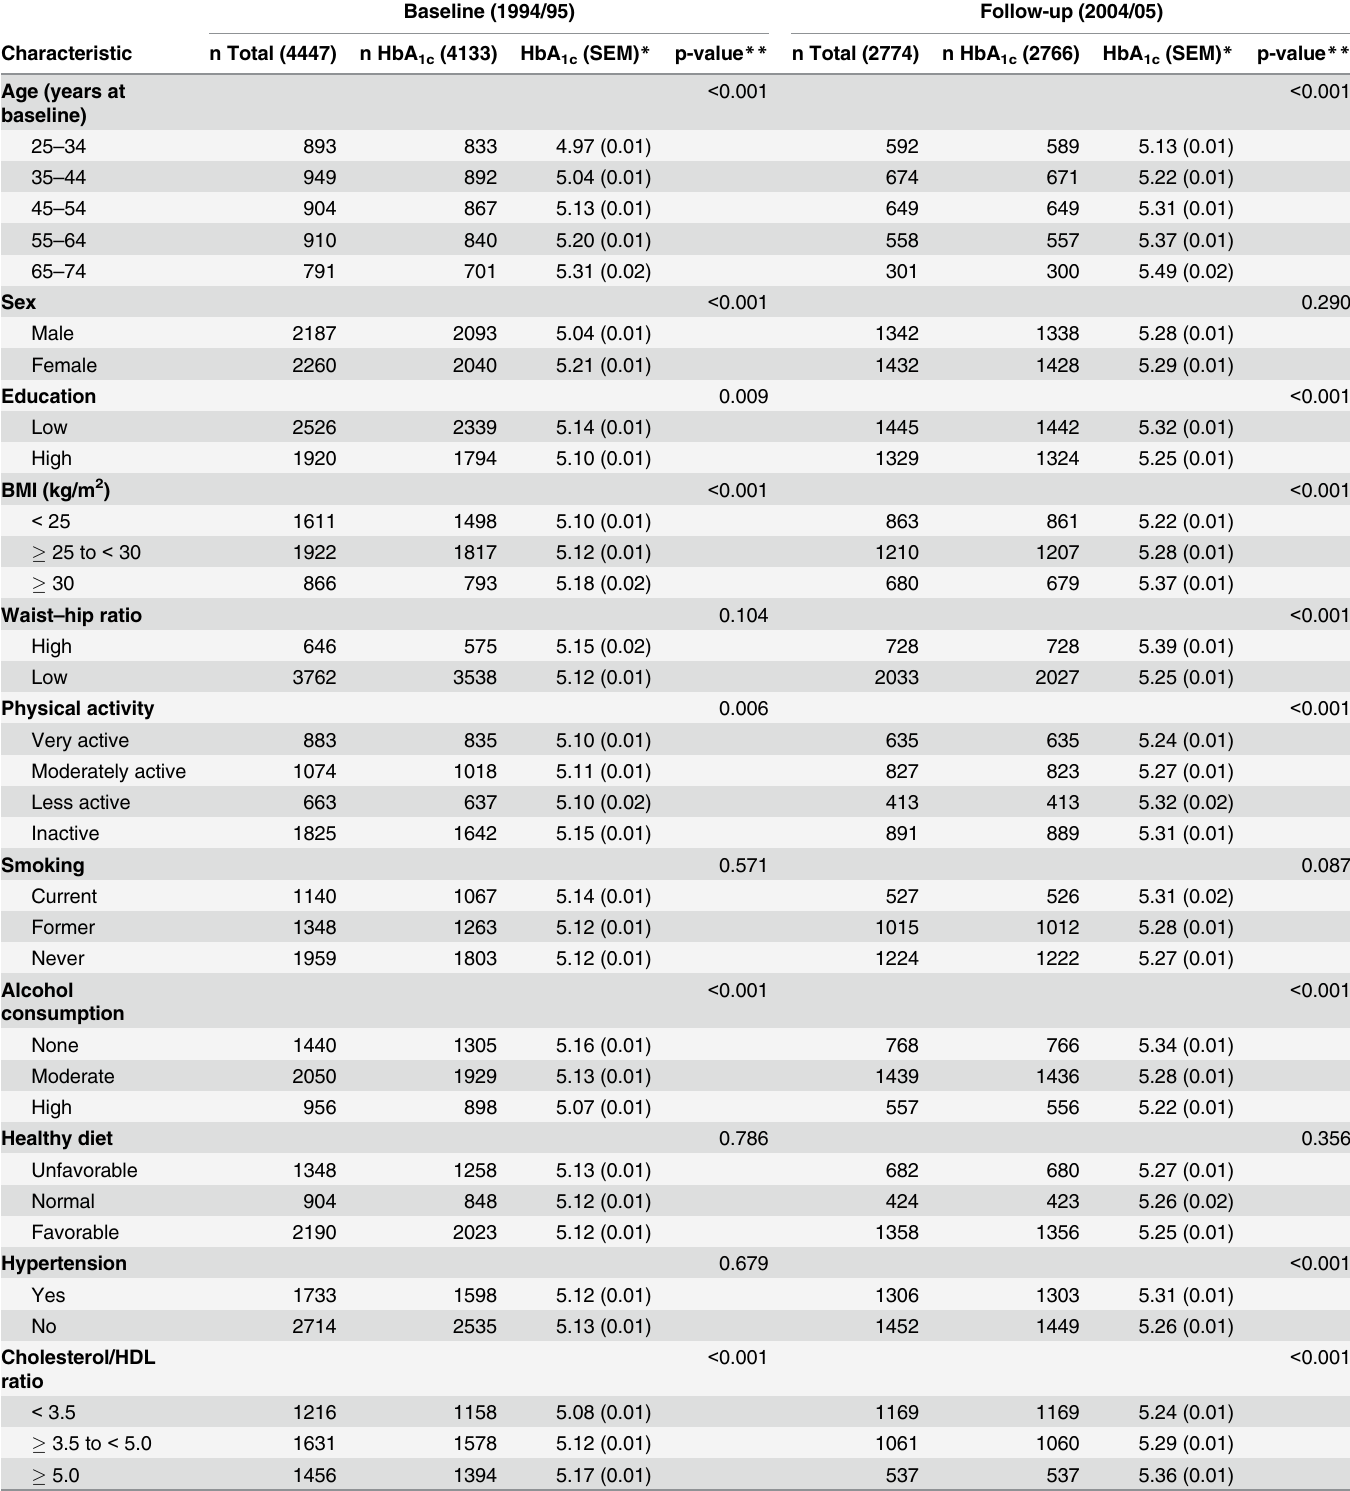
Table 1. Characteristics of the study population with adjusted mean levels of HbA 1c at baseline (1994/95) and follow-up (2004/05). Baseline (1994/95) Follow-up